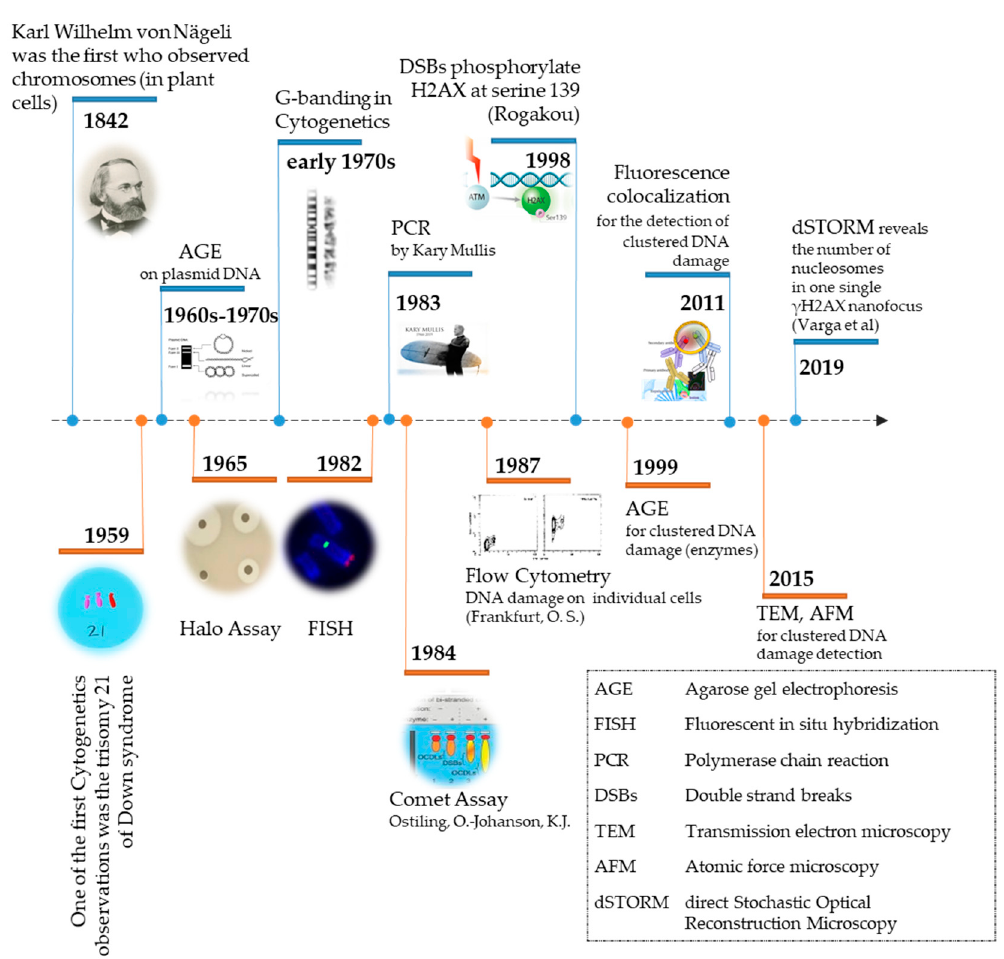
Figure 1. Evolution of experimental methodologies towards the detection of DNA damage at the DNA or chromosomal level from Agarose Gel Electrophoresis (AGE) to Super-Resolution Microscopy.